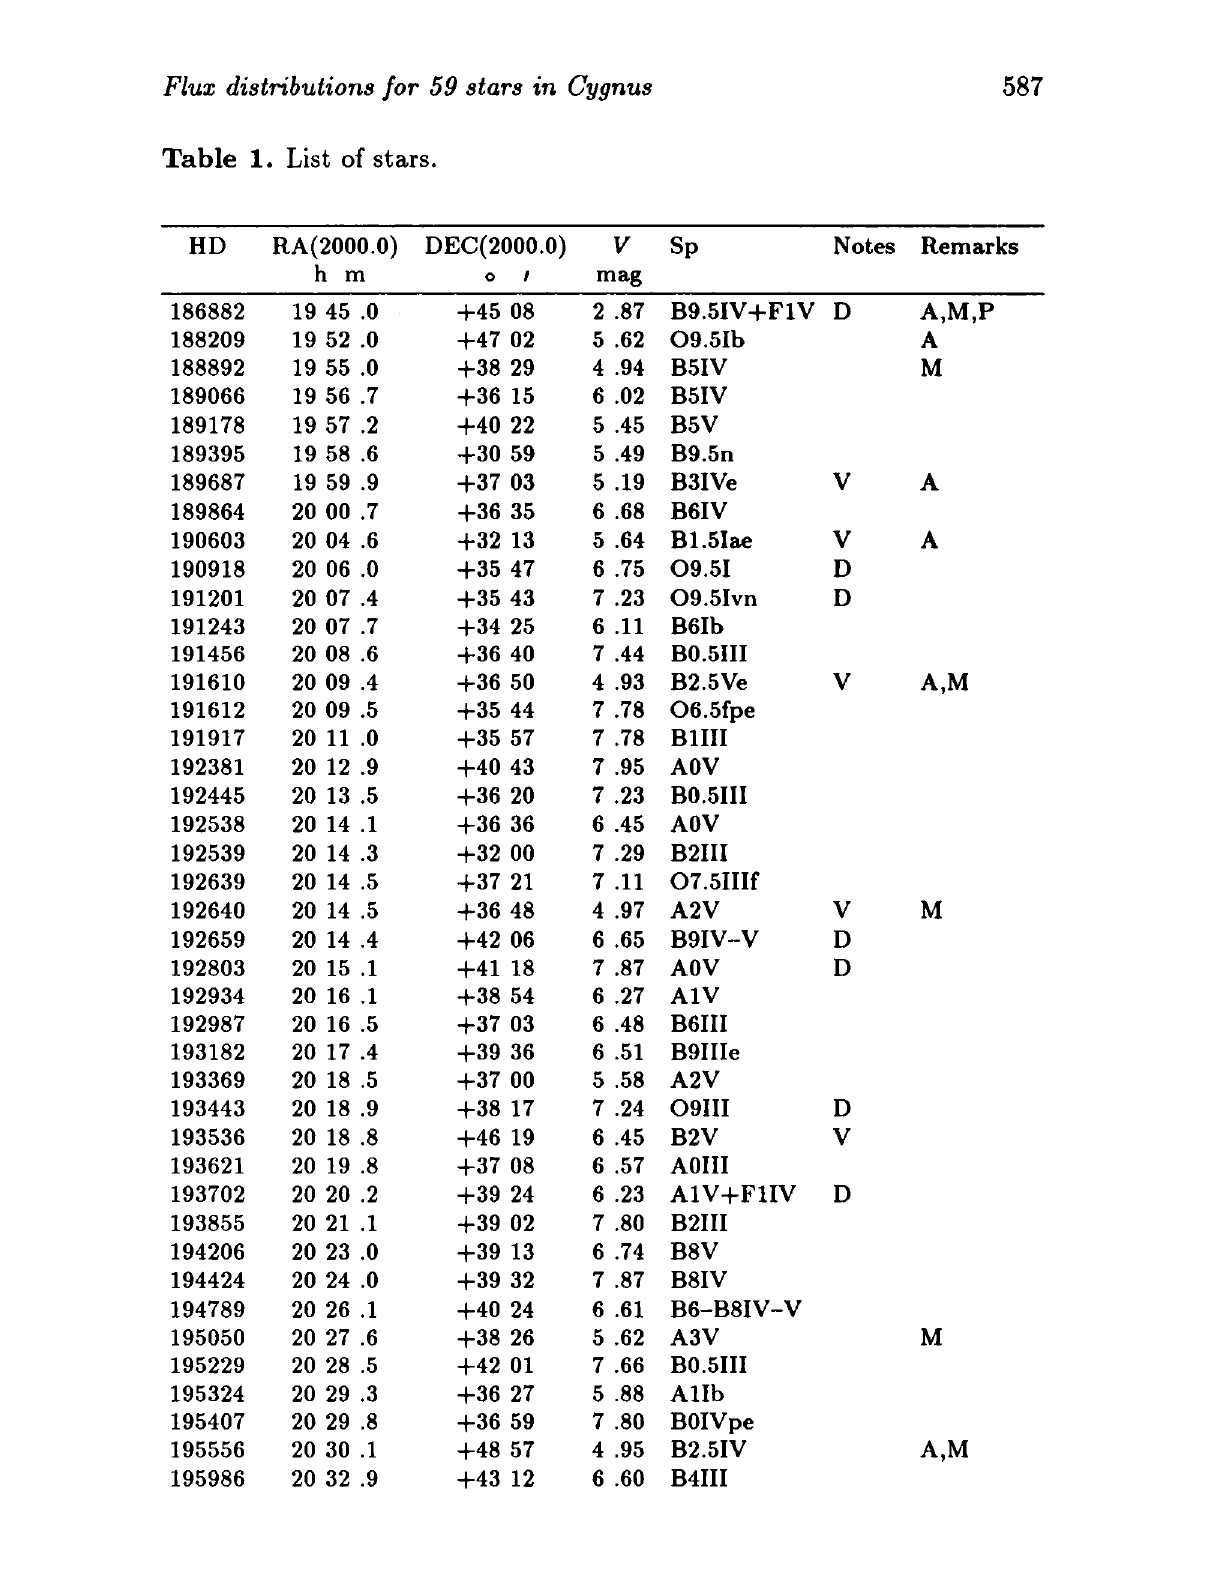
Table 1. List of